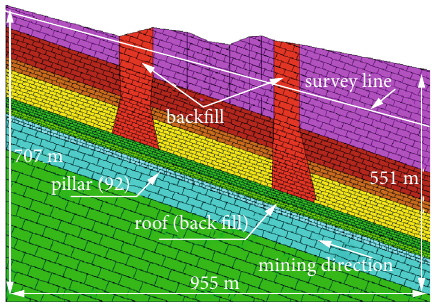
Figure 11: Mining model of No. 92